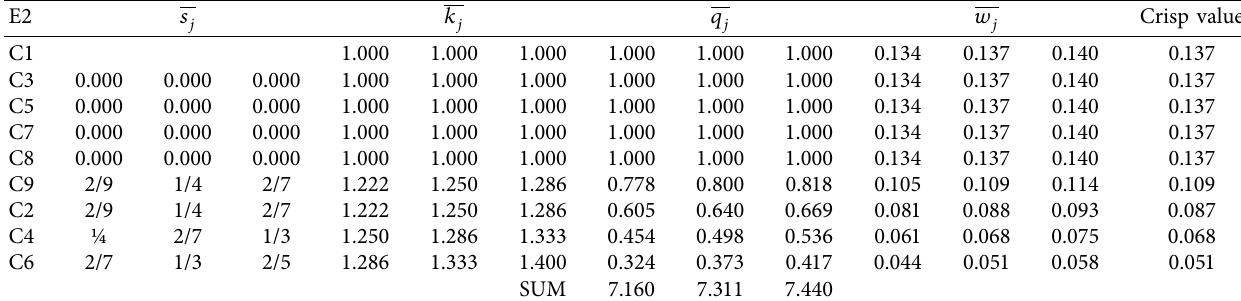
Table 4: Calculation and values of weight coefficients obtained by the IMF SWARA method for